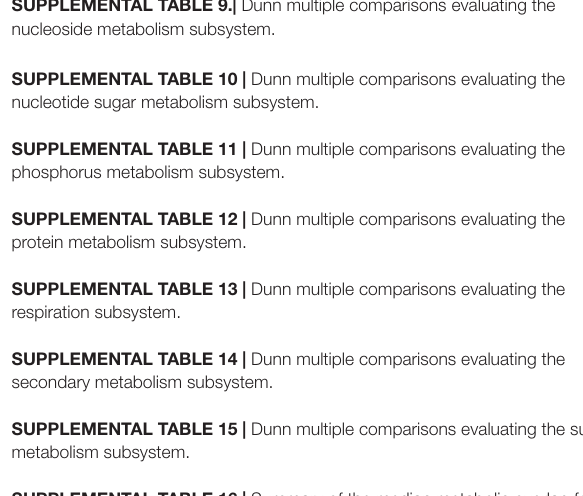
SUPPLEMENTAL TABLE 2 | Kruskal–Wallis test statistics for differences in metabolic overlap for different categories of metabolisms grouped by SEED subsystems.